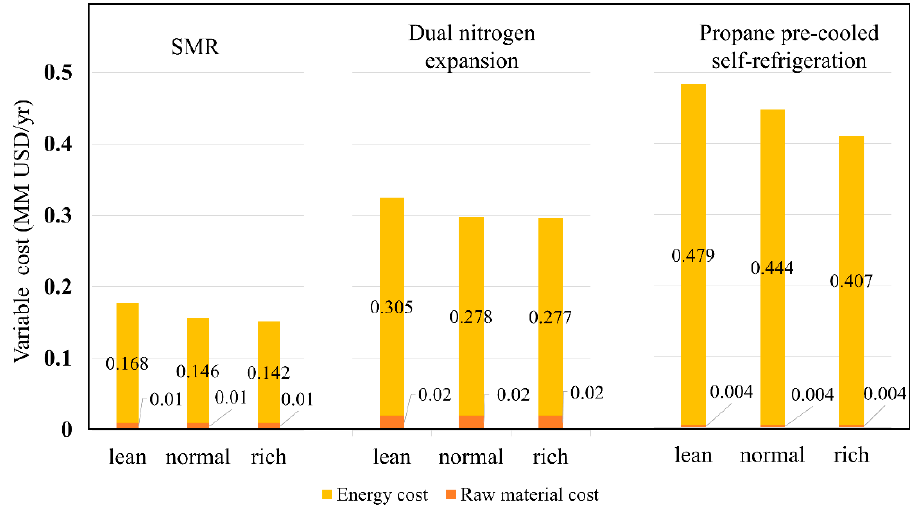
Figure 12. Effects of the natural gas compositions on the variable cost of each process.